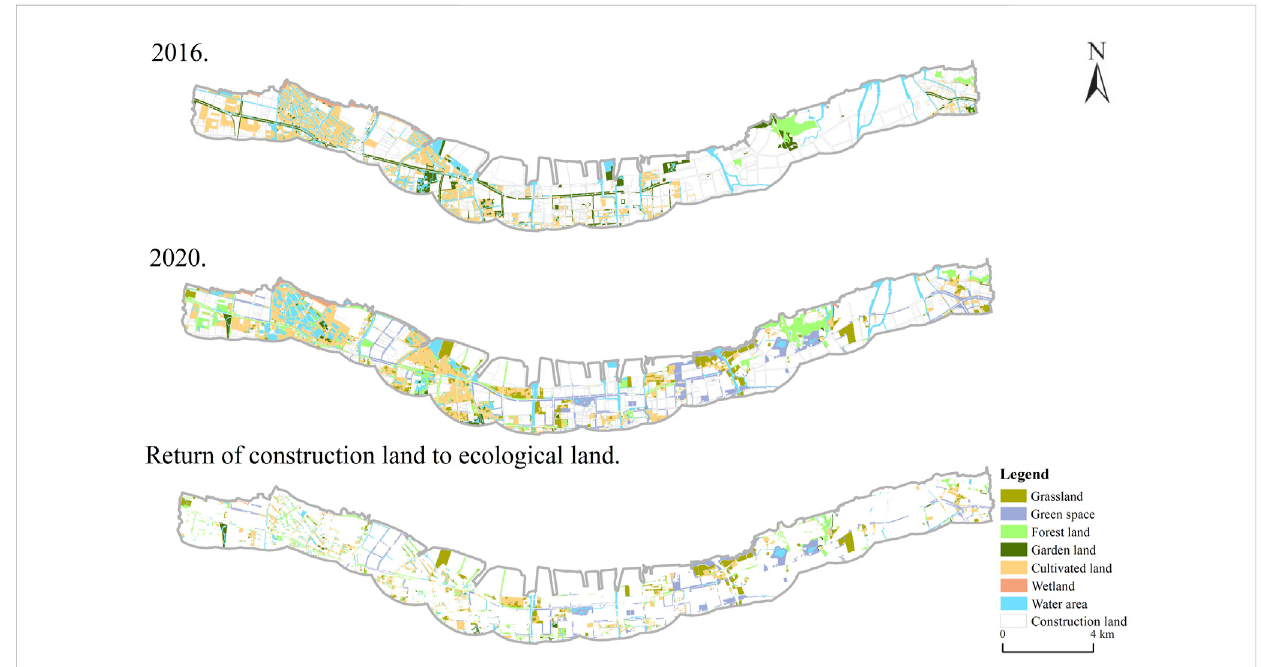
FIGURE 2 Land use situation and changes of return of construction land to ecological land in the study area of Jiangyin in 2016 and 2020.